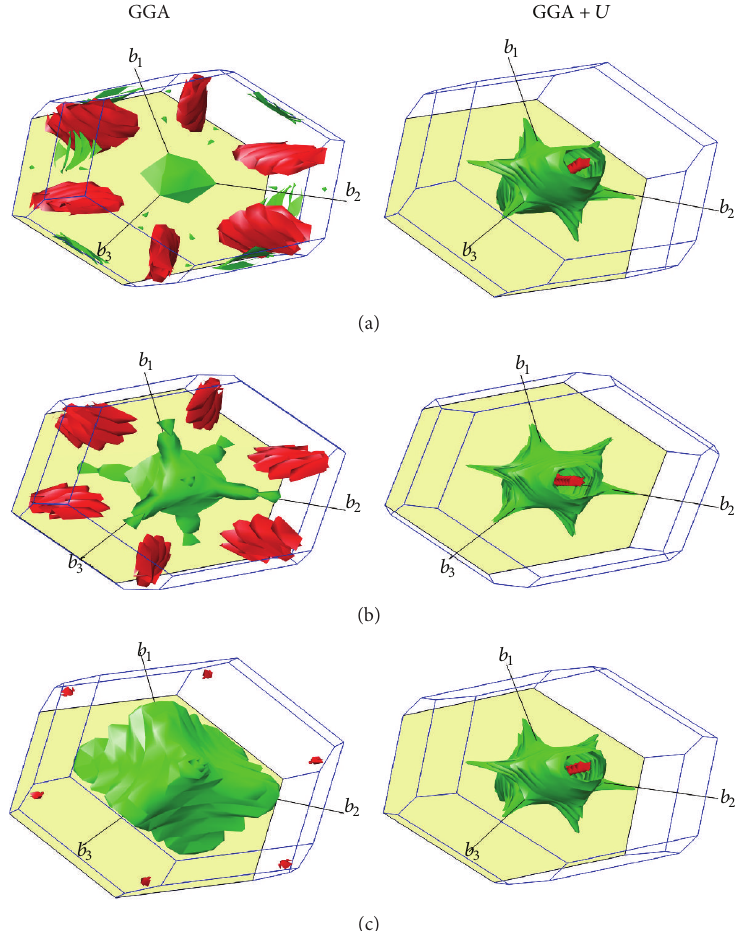
Figure 7: Fermi surface of CeS for GGA + 𝑈 with 𝑈 = 6